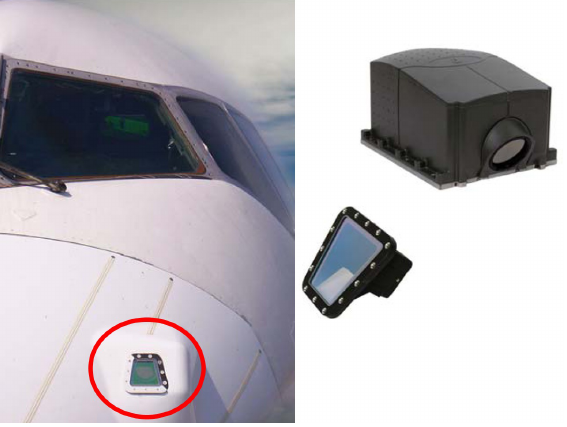
Figure 1. Infrared data sensor in EVS system. Credit: Kollsman !